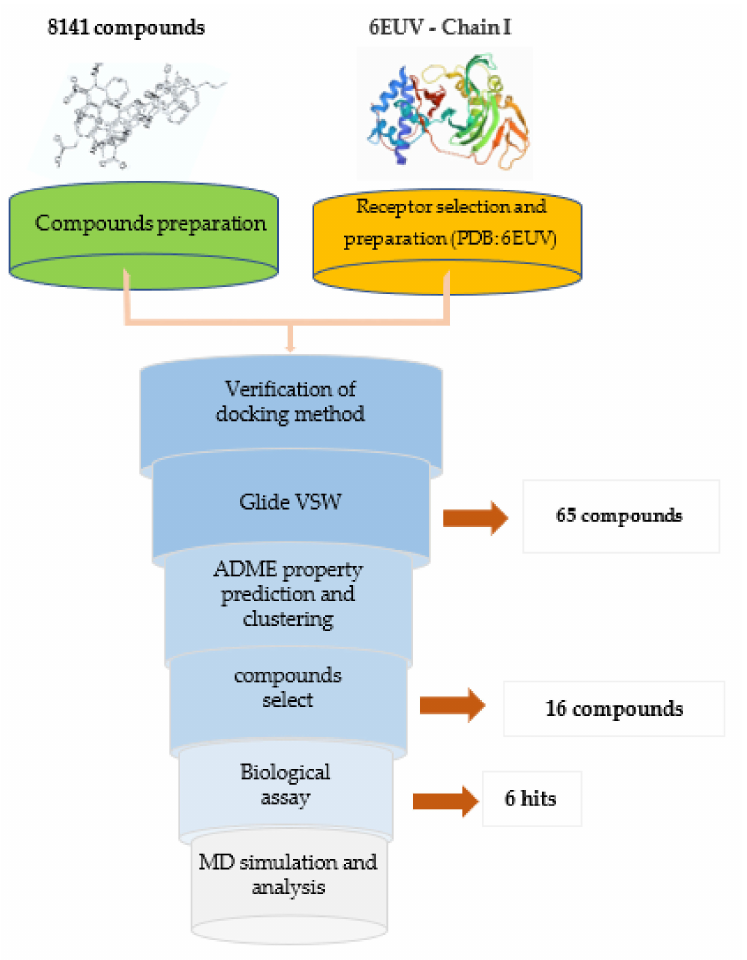
Figure 7. Stepwise flow diagram of the present